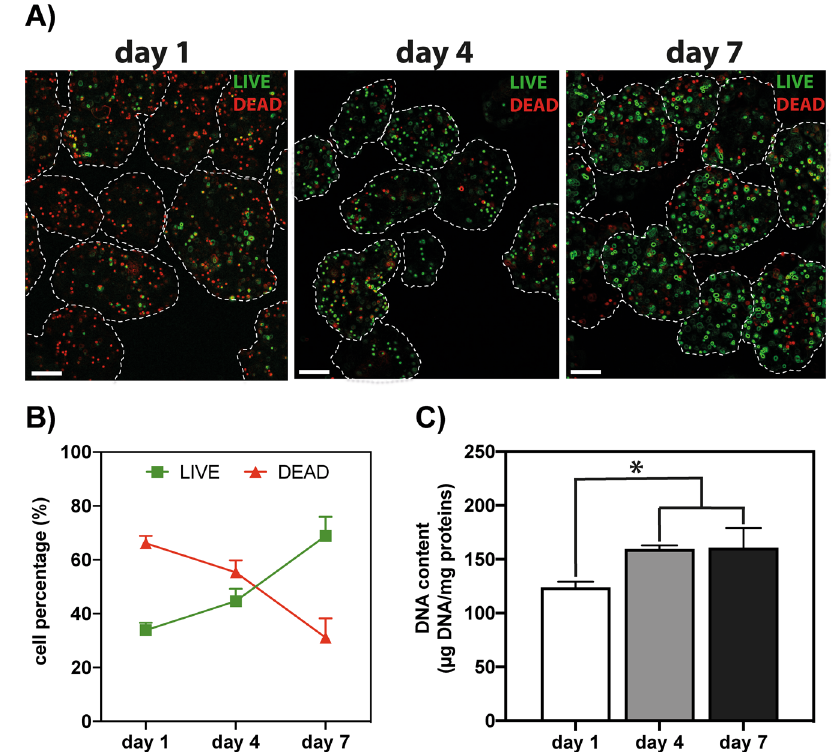
Fig. 4 Biochemical characterization of L929 cell- encapsulating SF µgels. A Live/ Dead fl uorescence images of L929 cells encapsulated in 30 MB SF µgels and cultured for 1, 4, and 7 days (green: live; red: dead; scale bar: 100 µm; 40× magni fi cation). B Quanti fi cation of cell viability of encapsulated L929 cells in SF µgels cultured for 1, 4, and 7 days post-cell encapsulation, expressed as the percentage (%) of live and dead cells. C Quanti fi cation of DNA content in L929-encapsulating SF µgels cultured for 1, 4, and 7 days. Data are expressed as µg DNA per mg of SF within the